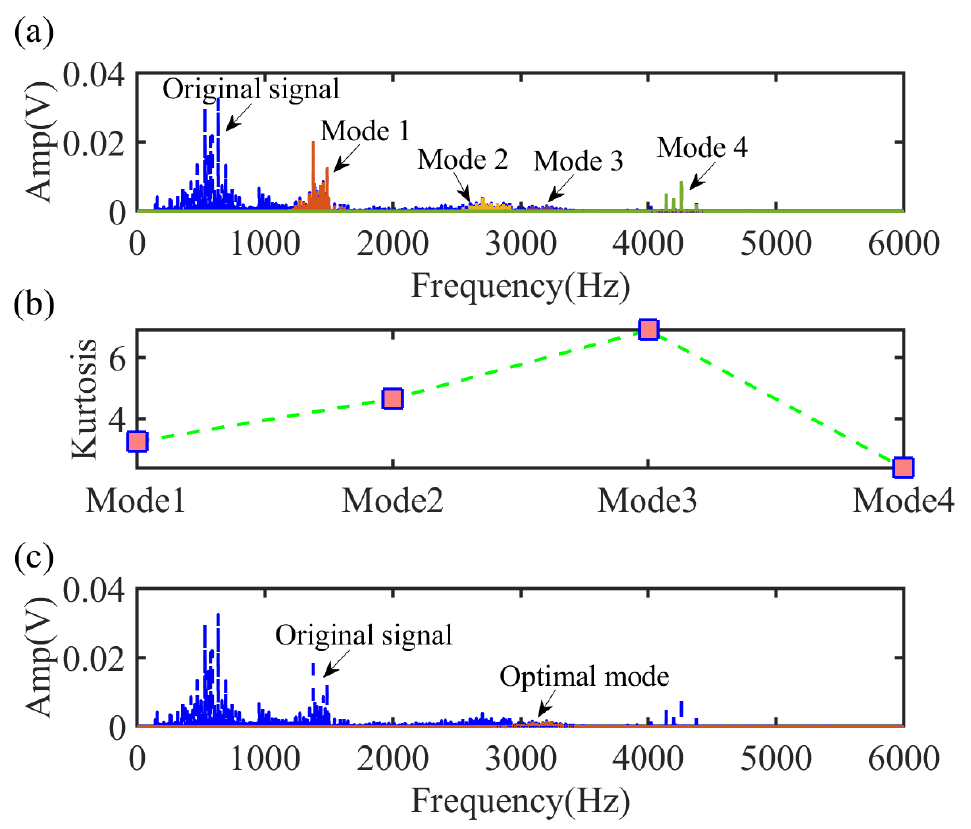
Figure 6. Extraction result by the proposed method: ( a ) extracted modes; ( b ) the kurtosis of different modes; ( c ) the optimal target mode.